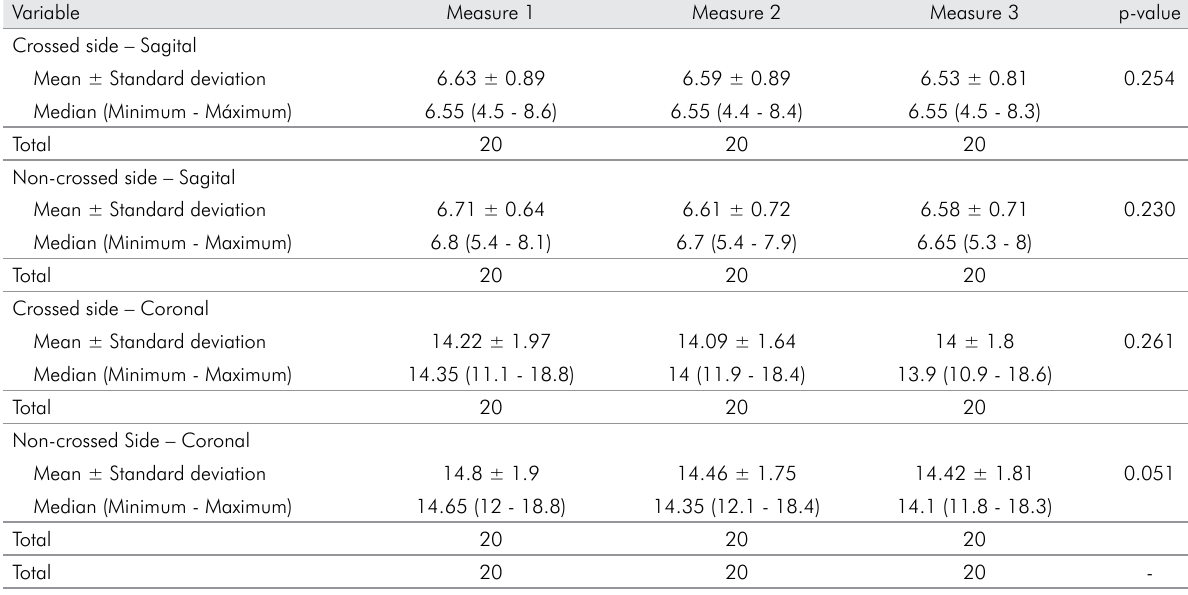
Table 1. Descriptive analysis of data and results of three measurements to assess intraexaminer errors using model analysis of variance (ANOVA) for repeated measures.